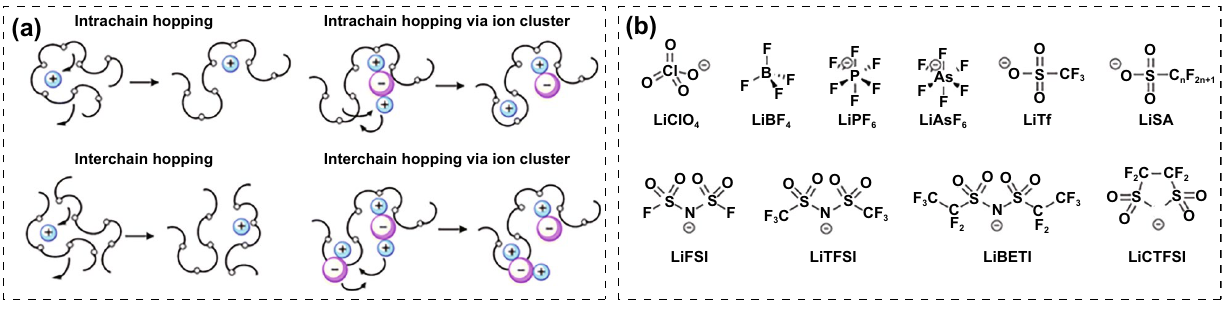
Fig. 5 a Li + ions diffuse through the polar groups and segment movement of the polymer chains [26]. Copyright 2018, Royal Society of Chem- istry. b Common lithium salts used in PIEs [26]. Copyright 2018, Royal Society of